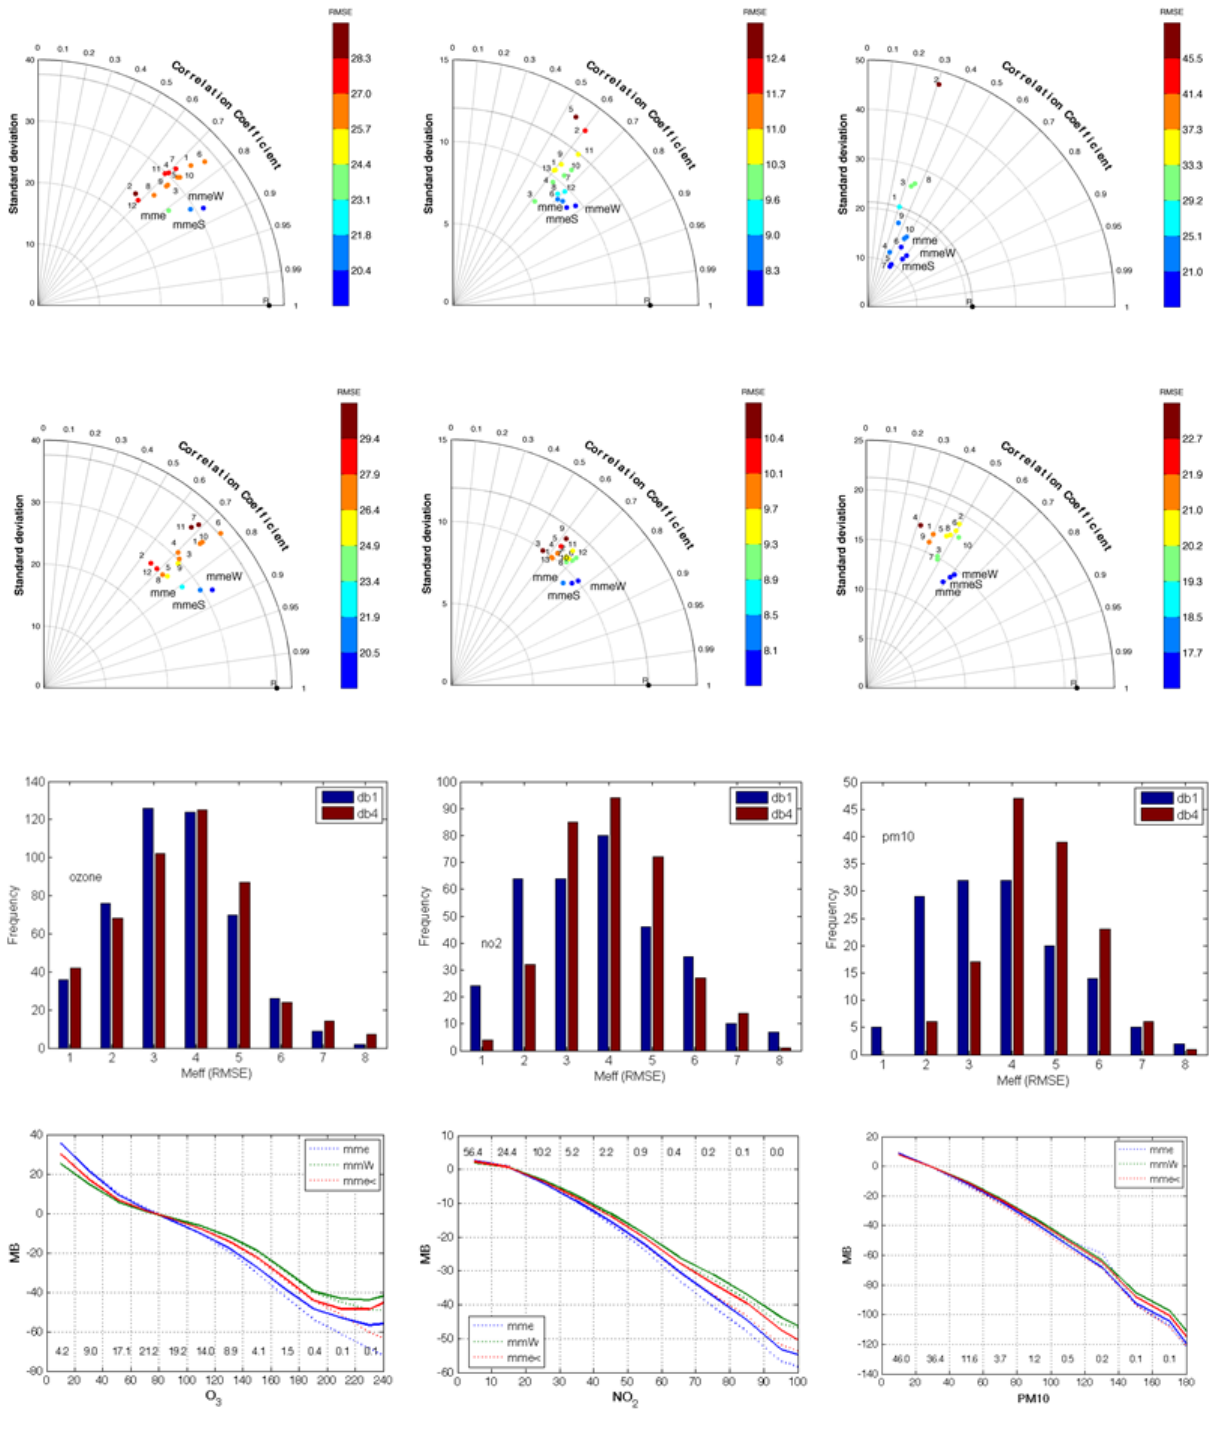
Figure 13. The Taylor diagrams in the first row refer to only bias correction (db1) while those in the second row refer to bias plus variance correction (db4). The bar plot in the third row shows the distribution of the effective number of models in the two schemes. The line plots in the last row compare the binned bias of the two correction schemes (db1: dotted, db4: line); the percentage of values within each bin is also given. Each column shows a different pollutant (O3, NO2, PM10). The plots have been produced from the aggregated time series incorporating all the stations of the test data set. Please note the different range of the x - and y -axes in the different